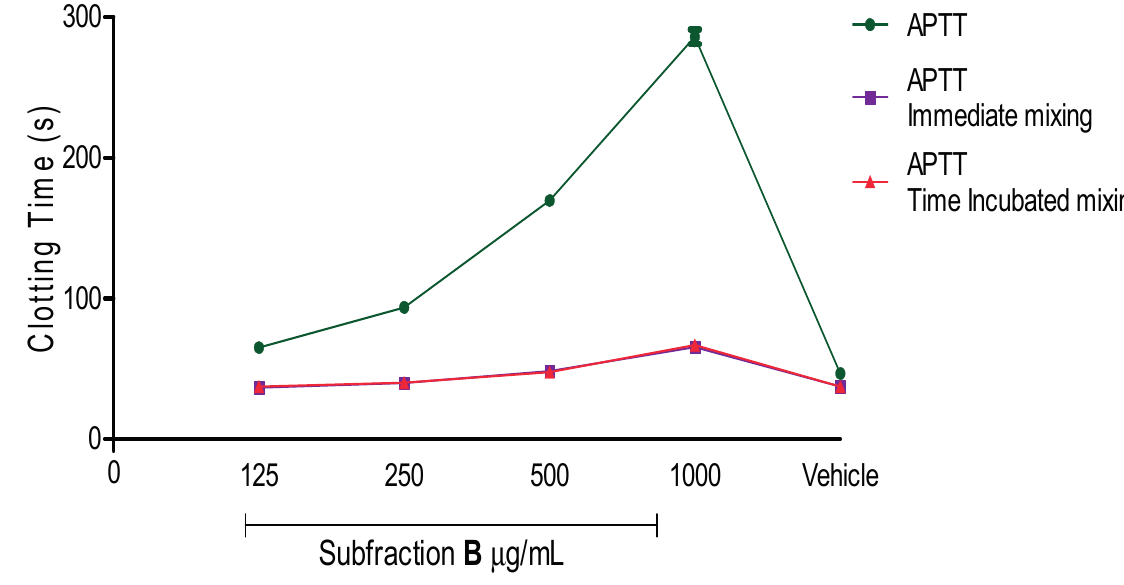
Figure 5. Activated partial thromboplastin time (APTT) and APTT immediate mixing as well as time incubation mixing studies of various concentrations of Subfraction